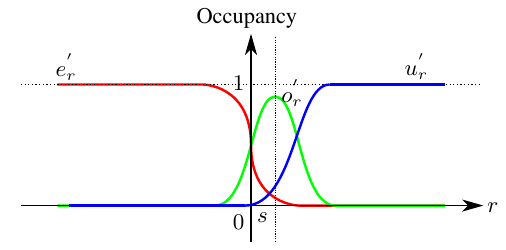
Figure 5: Occupancy in ray direction considering